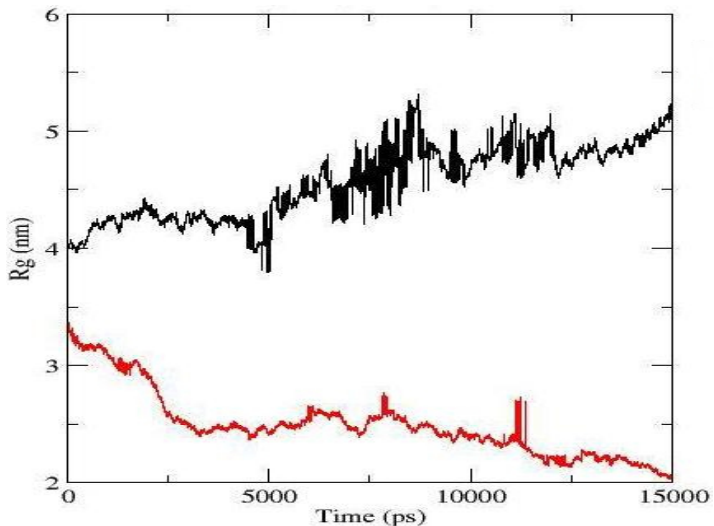
Figure 3. The radius of gyration, with fluctuation as a function of time for both simulations; black (OP/T80) and red (OP/T80/DIF).